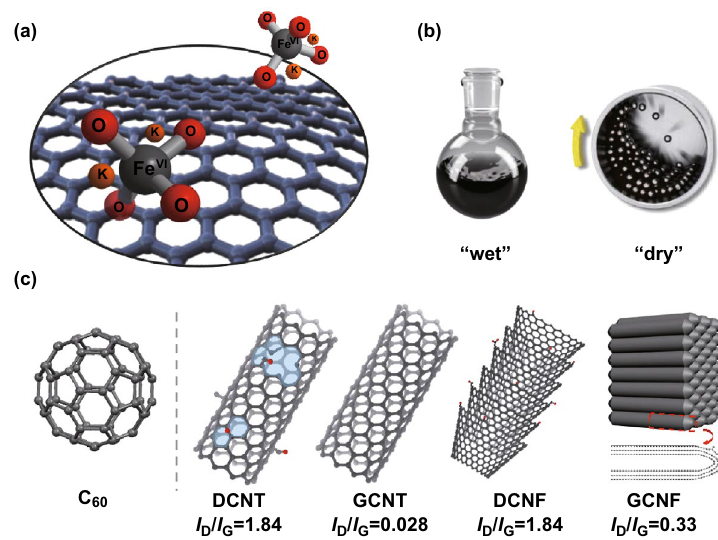
Fig. 1 a A schematic representation of K 2 FeO 4 –carbon reaction system. b Depiction of two reaction conditions (in H 2 SO 4 medium or by solid‑ state ball milling). c Structural models of the carbon nanomaterials used in this study: C 60 , defective CNT (DCNT), graphitized CNT (GCNT), defective and graphitized carbon nanofibers (DCNF and GCNF). I D / I G refers to the relative intensity of D to G band in Raman spectrum, taken as a measure of defect